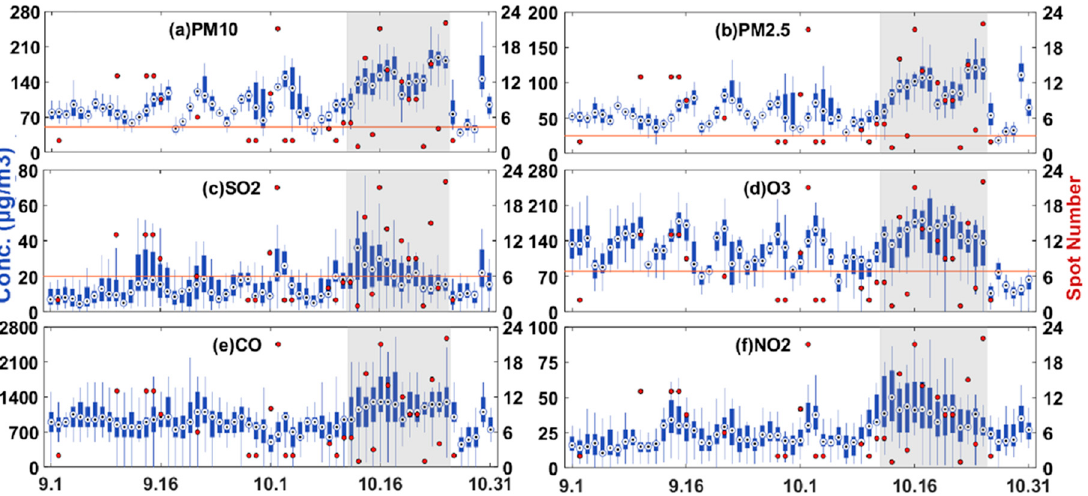
Figure 2. 24-h average concentrations of PM 10 ( a ), PM 2.5 ( b ), SO 2 ( c ) O 3 ( d ), CO ( e ) and NO 2 ( f ) and daily maximum 8-h average concentration of O 3 ( c ) at all monitoring stations from September to October 2015. The orange horizontal lines represent the WHO guideline for 24-h PM 10 , PM 2.5 and SO 2 and 8-h O 3 , which are 50 µ g / m 3 , 25 µ g / m 3 , 20 µ g / m 3 , 100 µ g / m 3 , respectively. The red point in each subplot represents the number of fire spots for each day.